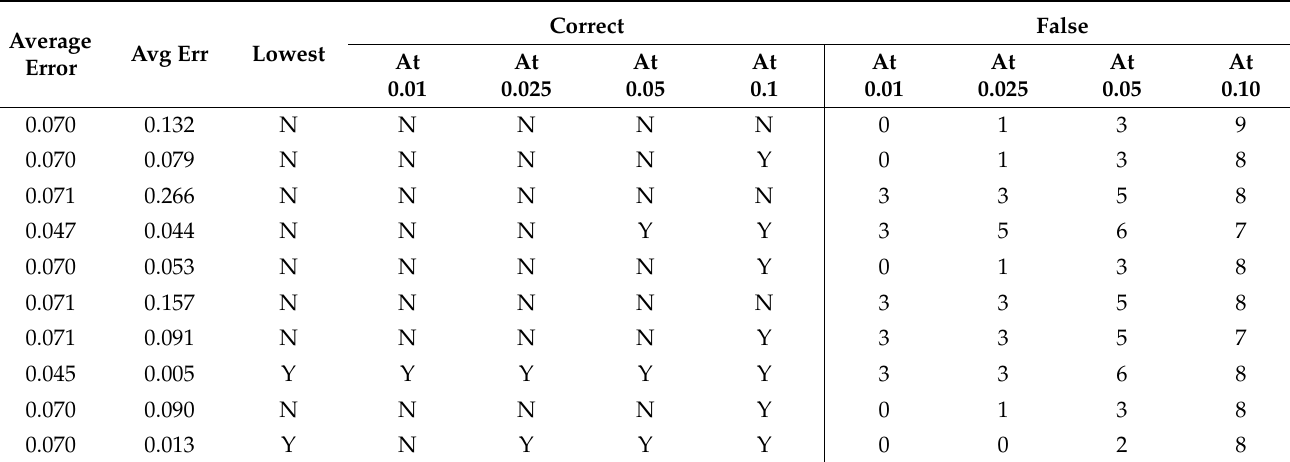
Table A230. Set 3, trials 41–50 summary data (all 0.5 PR